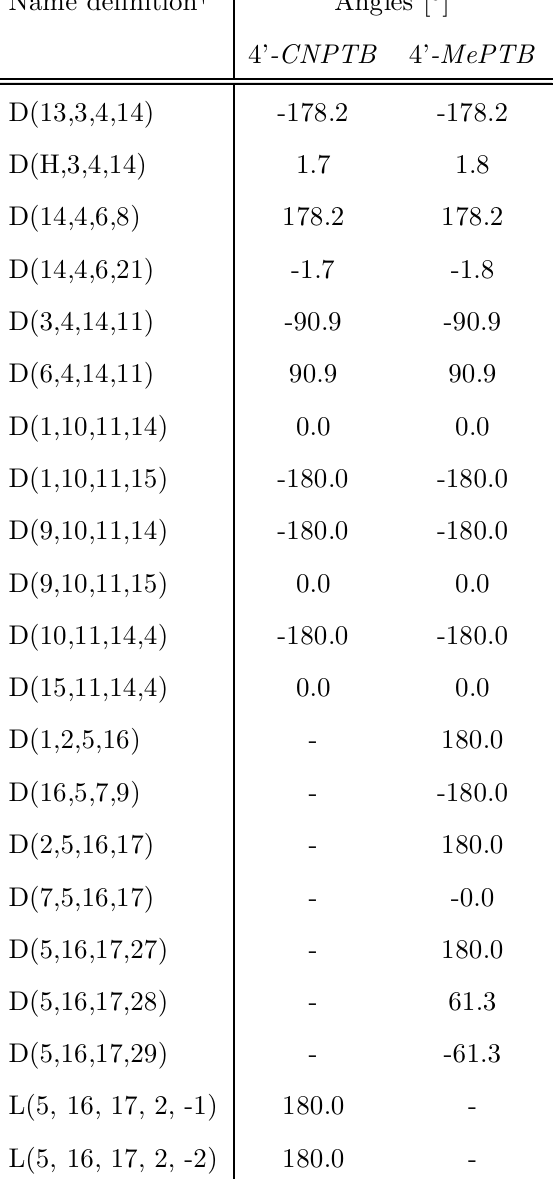
Table 1 (second half) Selected structural parameters, optimized for 4’-CNPTB and 4’-MePTB. A(C ar C ar C ar ) range within 119.9096 { 120.6084 (4’-MePTB); 119.8815 - 120.3406 (4’-CNPTB) A(C ar C ar H) range within 118.8668 { 120.0970 (4’-MePTB); 118.9979 { 120.5593 (4’-CNPTB) y 4’-CNPTB/4’-MePTB